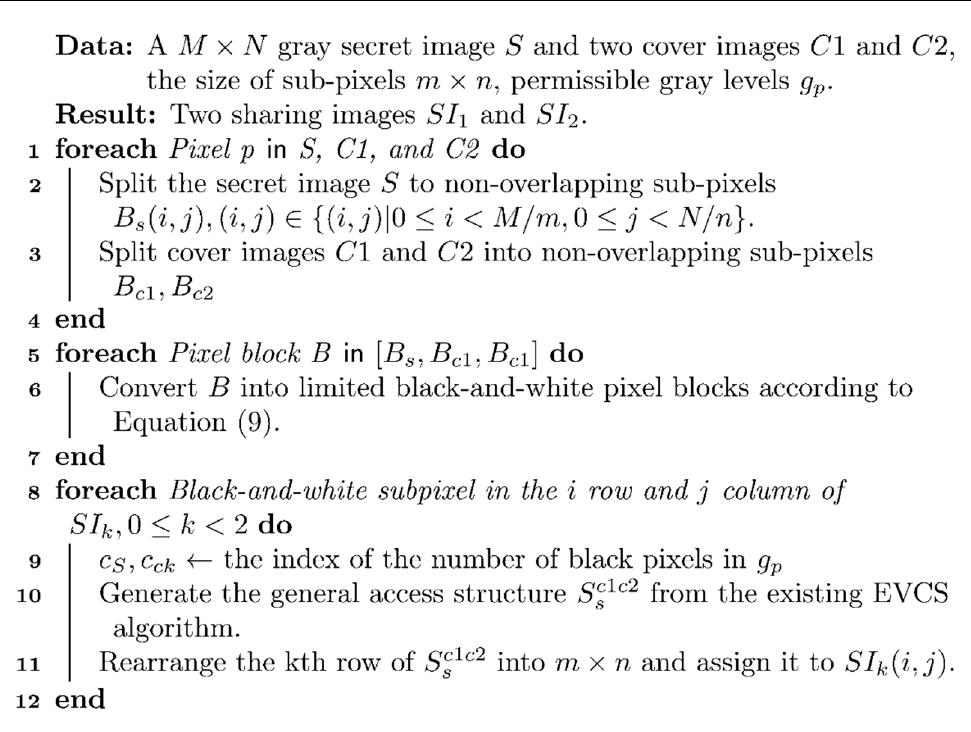
Algorithm 1 : The encoding process of the size-invariant